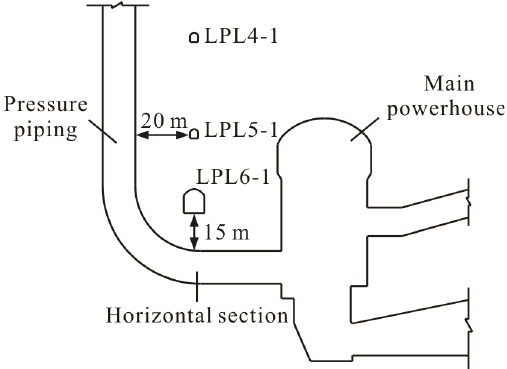
Figure 9. A cross-section of the underground